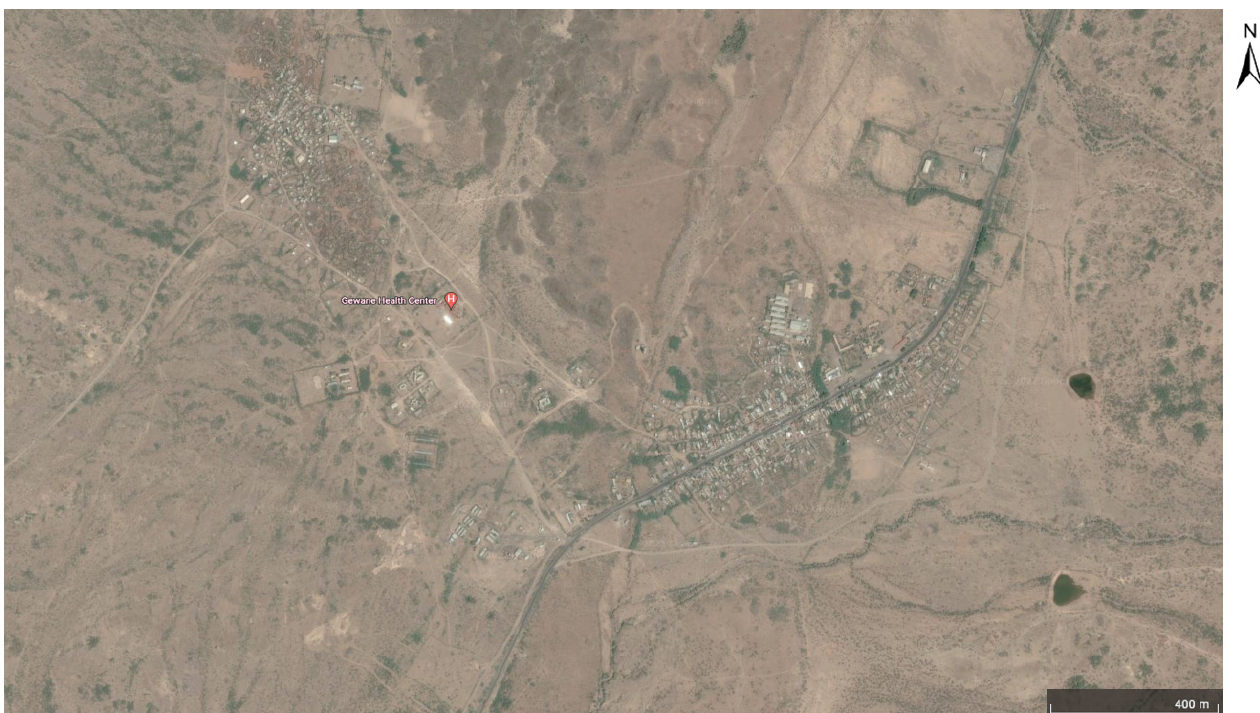
Figure 2. Satellite image of Gewane District, indicating the main health center. Source: Google Earth Pro. [Gewane District]. Retrieved 31 October 2022.